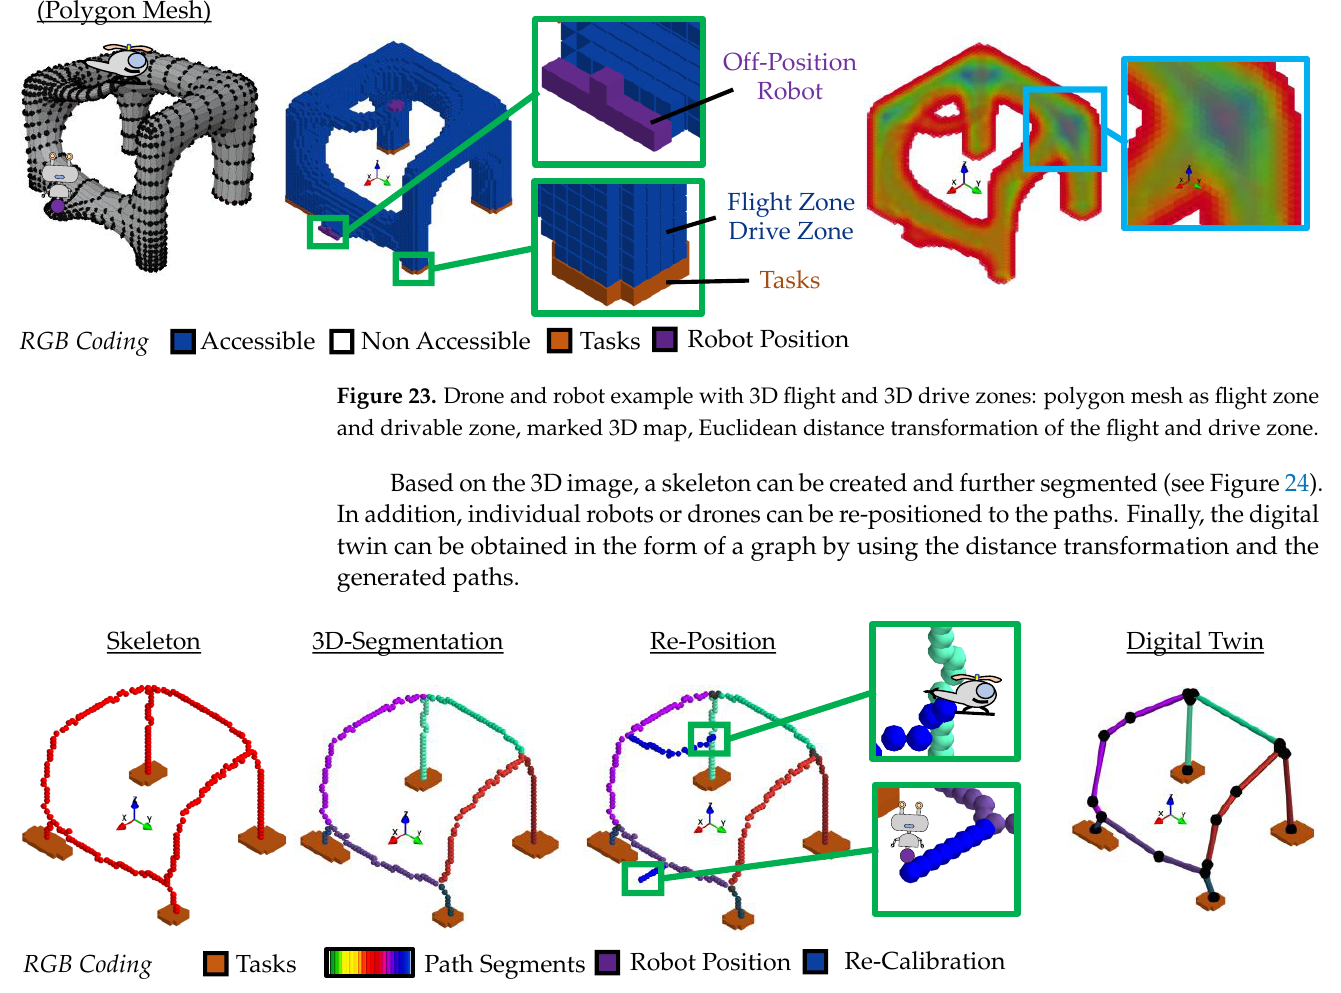
segmentation of the 3D skeleton, the derived graph for the digital twin.